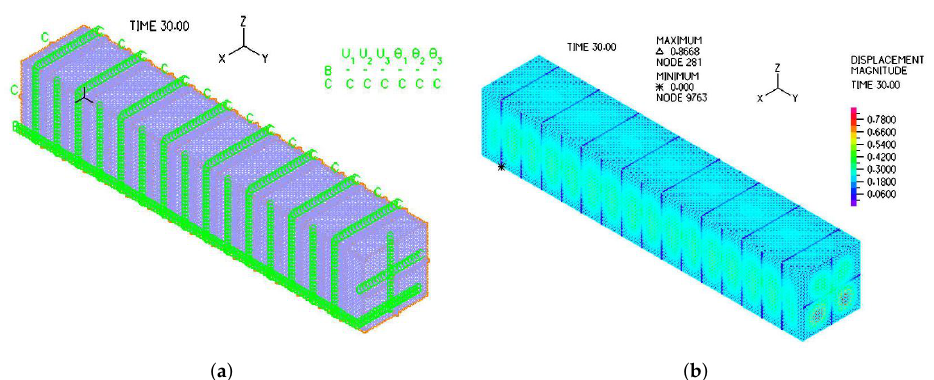
Figure 14. ADINA simulation of the full-fledged three-dimensional plate and beam model with stiffeners. ( a ) 3D plate and beam model, ( b ) Deformation.